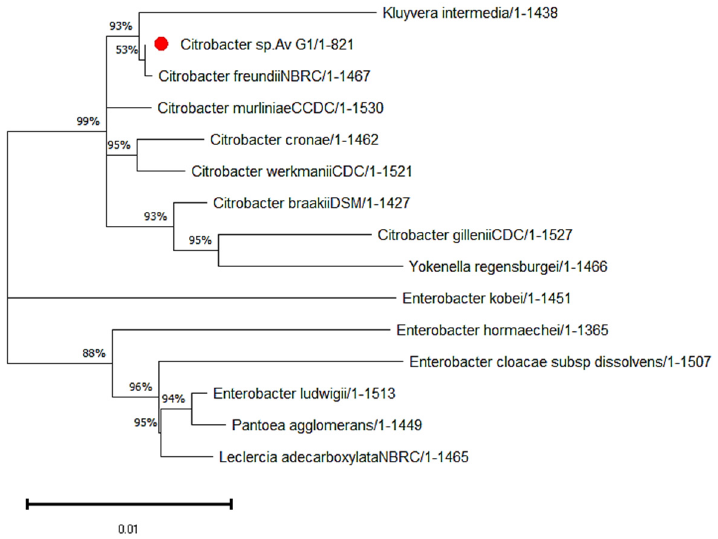
Figure 5. Phylogeny tree that was inferred using the maximum likelihood method and the Tamura–Nei model. The tree with the highest logarithmic probability ( − 2938.23) is shown.